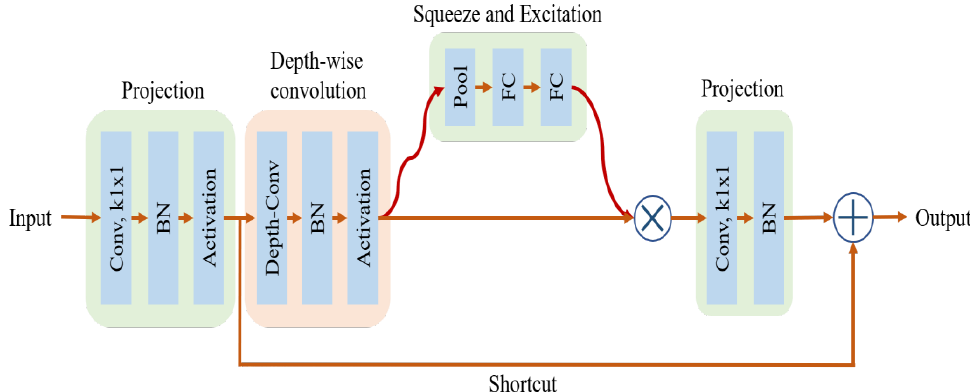
Figure 3. A mobile inverted bottleneck layer used for the EfficientNet family of models. (BN — Batch normalization layer; FC — Fully connected layer).